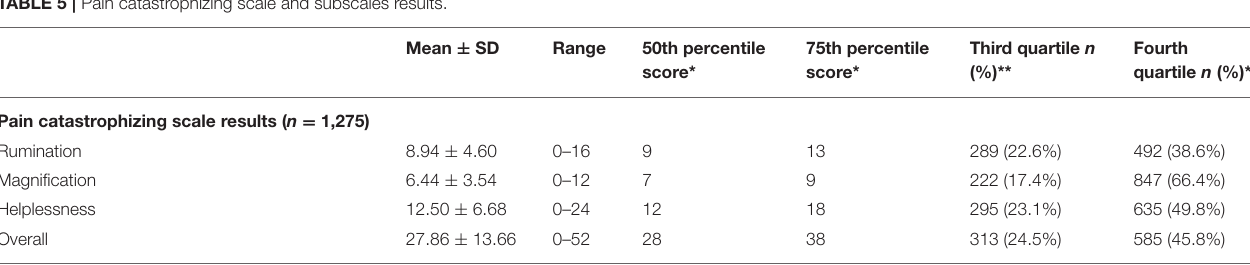
TABLE 5 | Pain catastrophizing scale and subscales